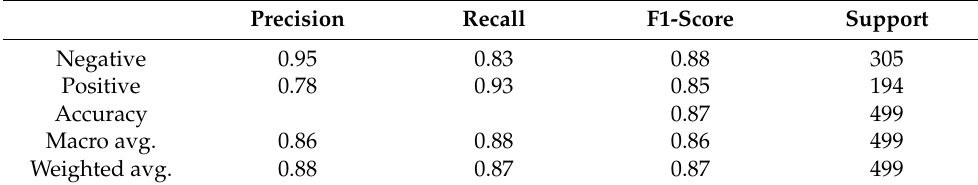
Table 4. BERT topic classifier performance: social issues.